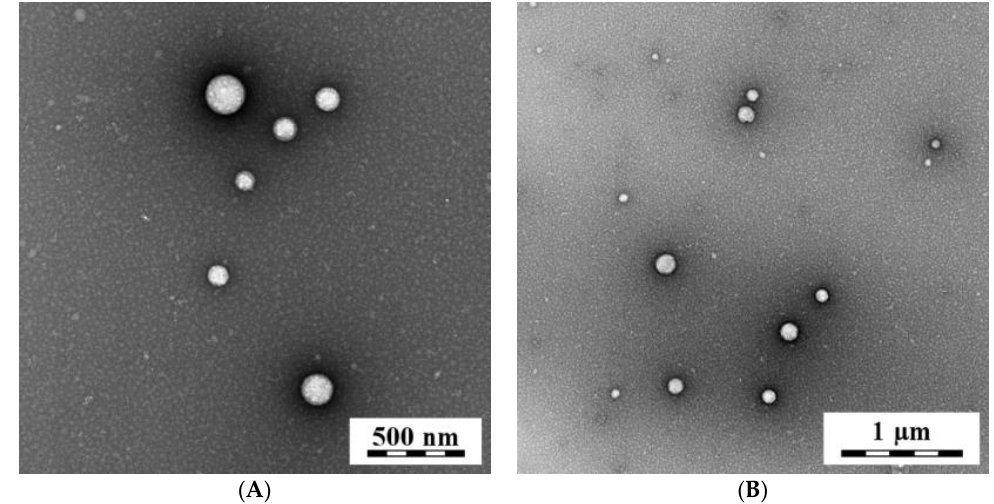
Figure 6. Transmission electron microscopy of the cashew gum particles with 10 % of α -tocopherol (CGNPs+10) prepared by nanoprecipitation, on the scale 500 nm (A) and 1 µm (B). Table 2. Parameters of the CGNPs third stage degradation with different concentrations of α -tocopherol. D 0.1 : initial de- composition temperature; D 1/2 : temperature values for the 50 wt.%; MRTD: the temperature for the maximum rate of de- composition; Residue: residue obtained at 600